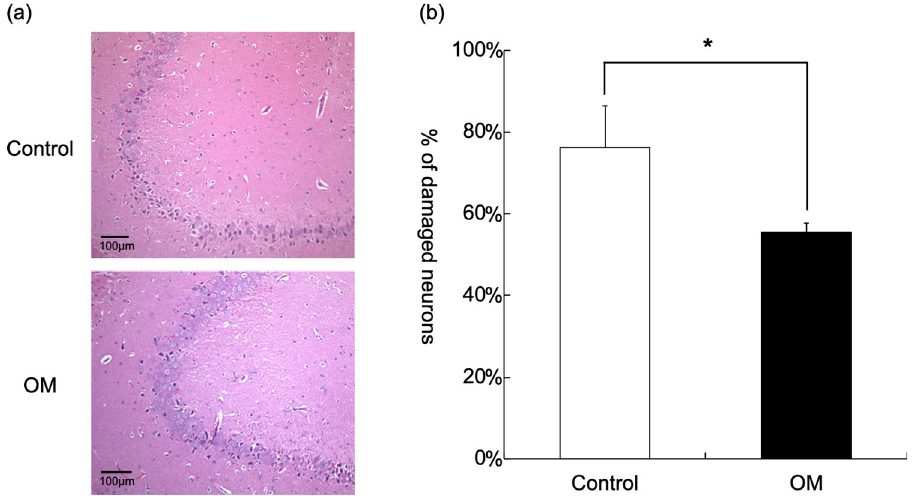
Fig 5. Histological examinations of the brain in control and OM groups. (a) Hematoxylin and eosin staining in brains 72 h after cardiac arrest. (b) Quantification of damaged neurons in each group. ( � : P = 0.004).